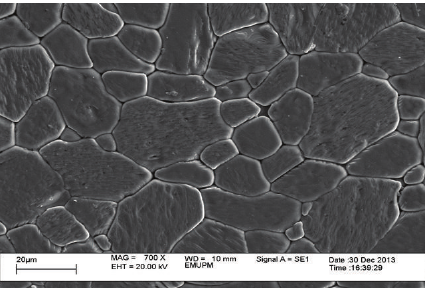
Figure 5: The microstructure of the validated varistor morphology.